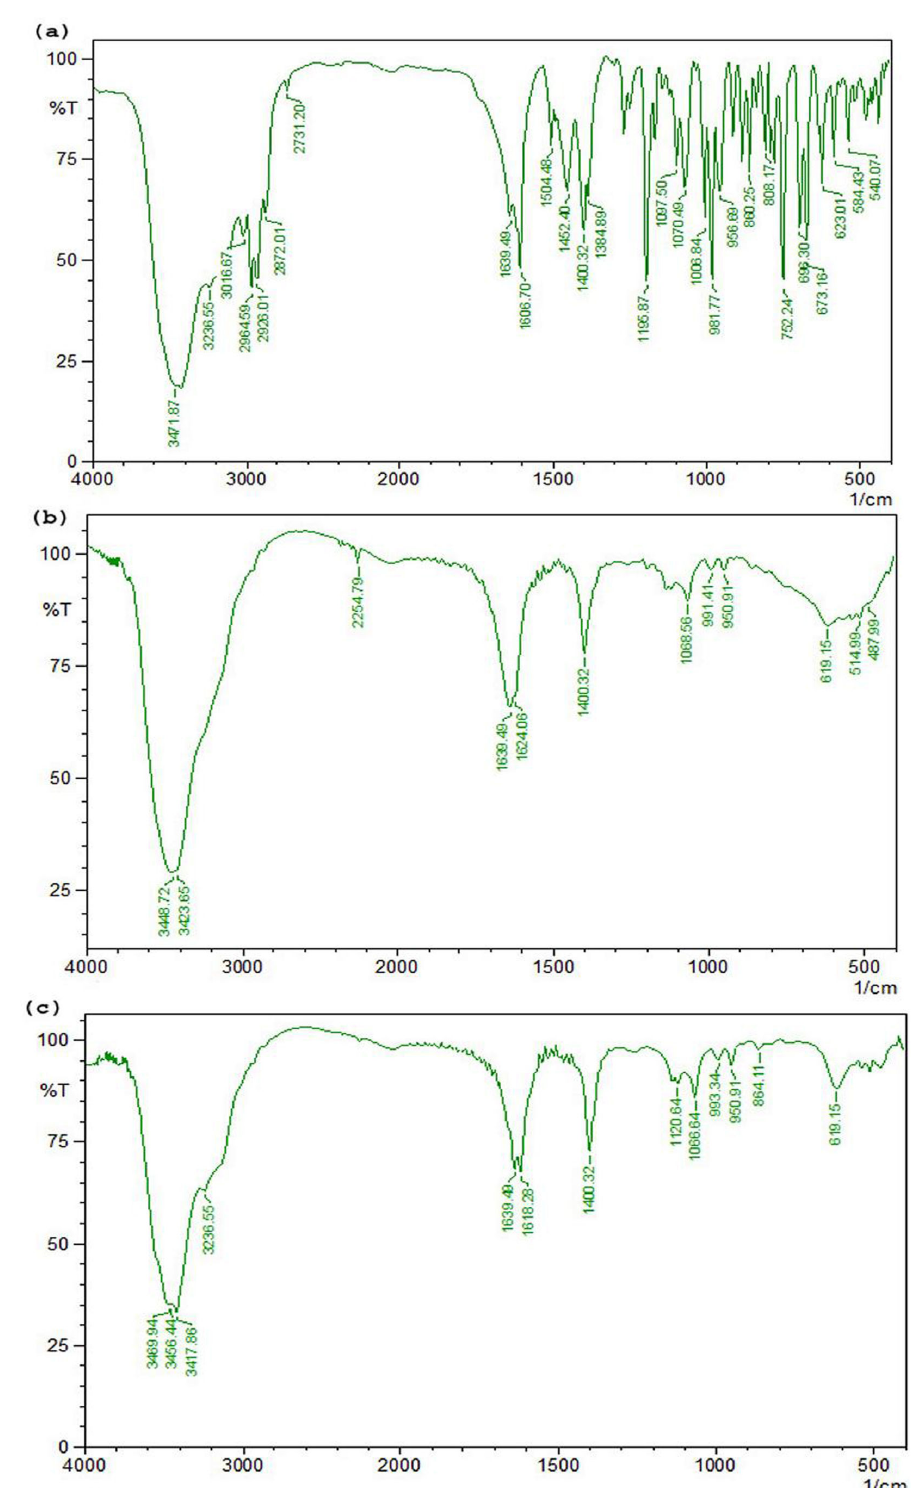
Figure 3. FTIR spectrum of endosulfan at (a) standard condition; (b) FTIR spectrum for the degradation of endosulfan and its metabolites in aqueous medium by JAS6; (c) FTIR spectrum for the degradation of endosulfan and its metabolites in aqueous medium by JAS9.